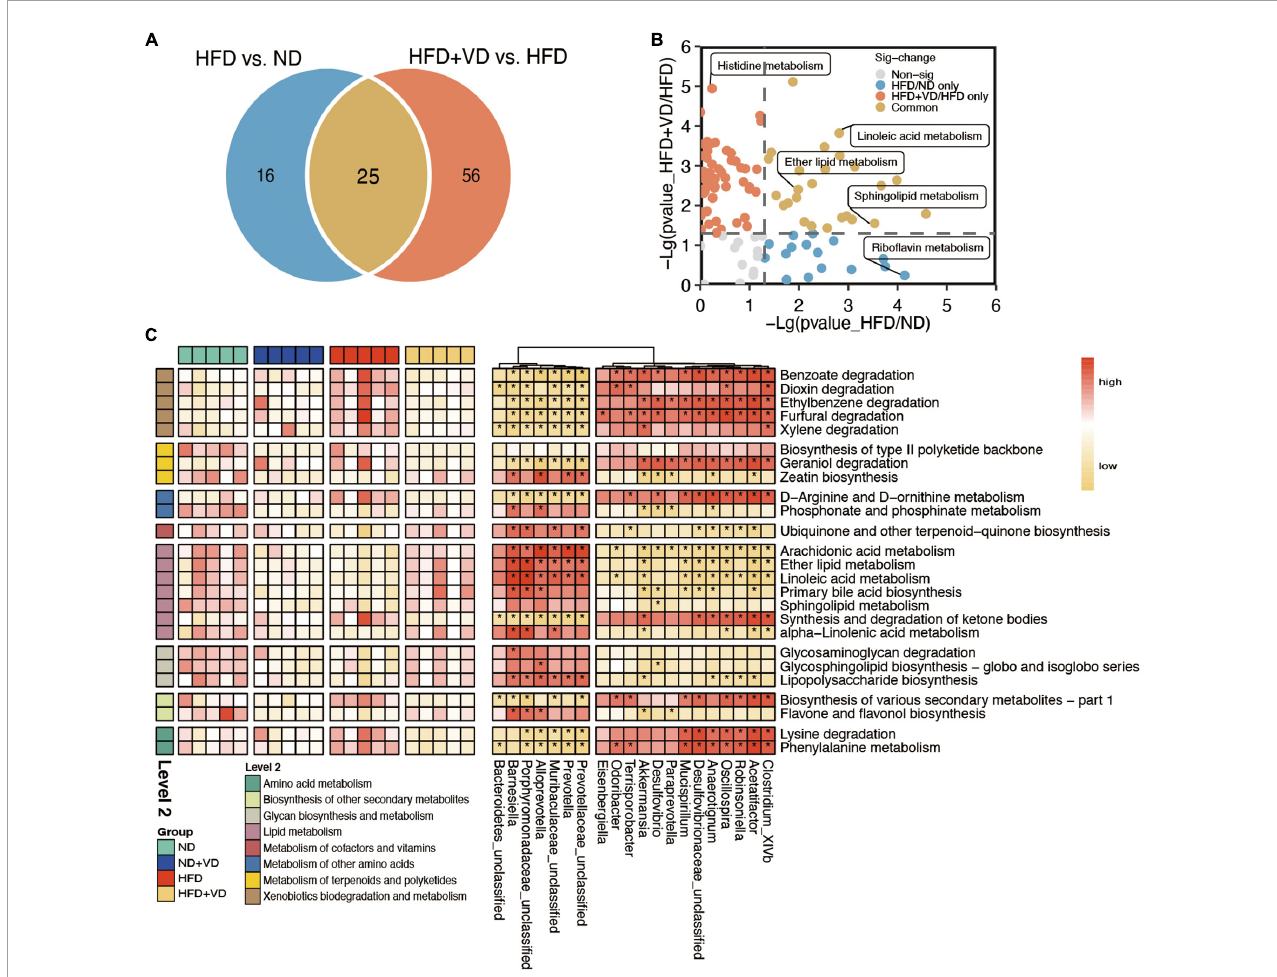
FIGURE4 The characteristic function of gut microbiota. (A) Venn diagrams illustrating the number of predicted pathways significantly changed between high-fat diet (HFD) vs. ND and HFD + VD vs. HFD. (B) The clear distinct difference between HFD vs. ND and HFD + VD compared to HFD, respectively. (C) The predicted function of bacteria and the connection between the predicated function of intestinal microbiota and altered gut microbiota. Red denotes positive correlations. Yellow denotes negative correlations. * P < 0.01.